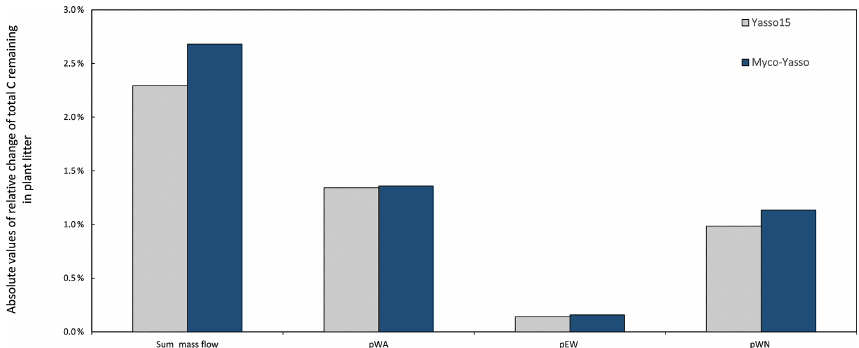
Figure C4. Sensitivity of Yasso15 and Myco-Yasso models to 1% increase in mass flow parameters. The two leftmost bars show the sensitivity to the joint impact of all p -term parameters being increased by 1%. The other bars show the impact of 1% increase in individual p terms: p WA – C flux from the W to A pool, p EN – C flux from the E to N pool, and p WN – C flux from the W to N pool.